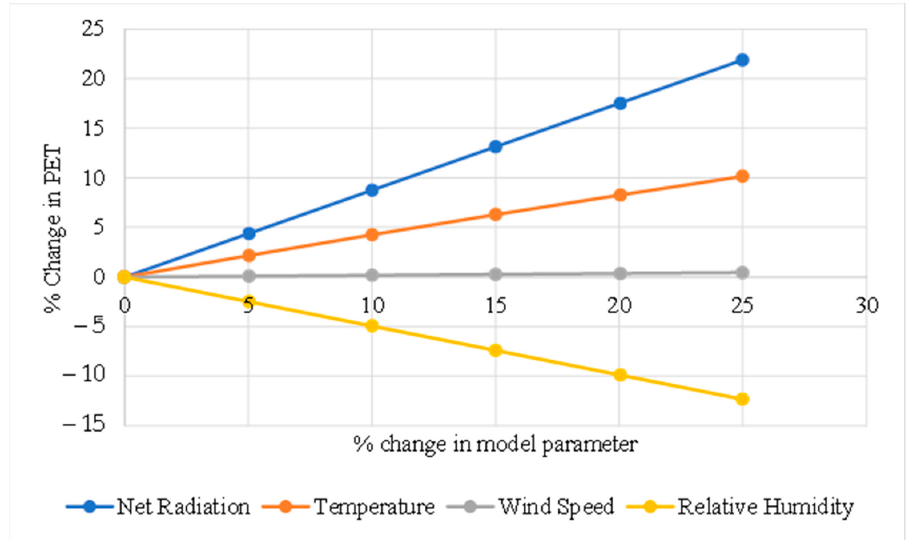
Table 2. Pearson correlation coefficient (R) between PET estimates (from FAO P–M and S–W models) and models’ meteorological parameters, and p values.